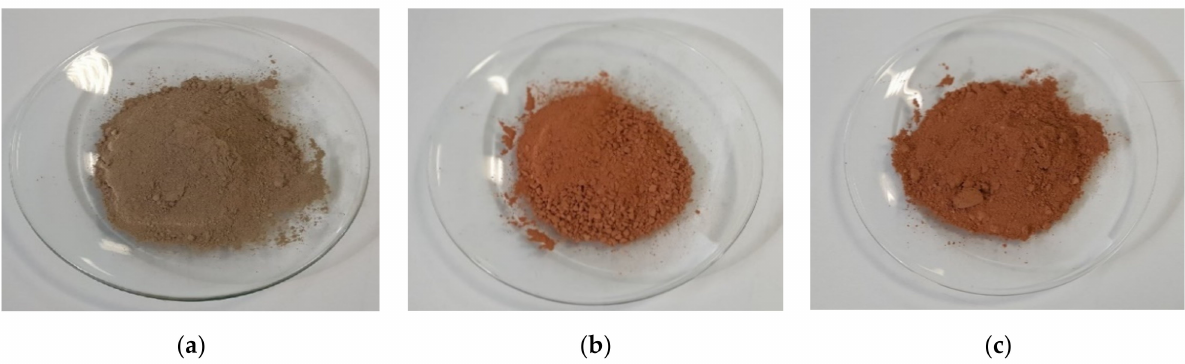
Figure 4. Visual aspect of ( a ) raw dried; ( b ) calcined and ( c ) crushed calcined